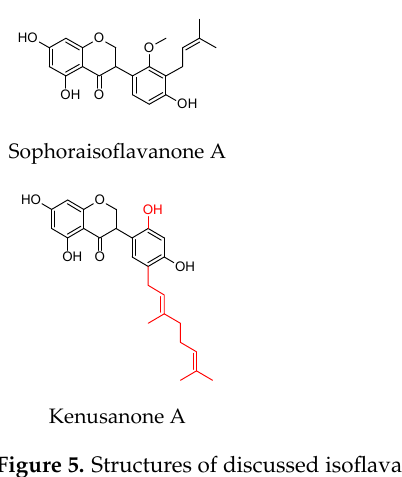
Figure 5. Structures of discussed isoflavanones.